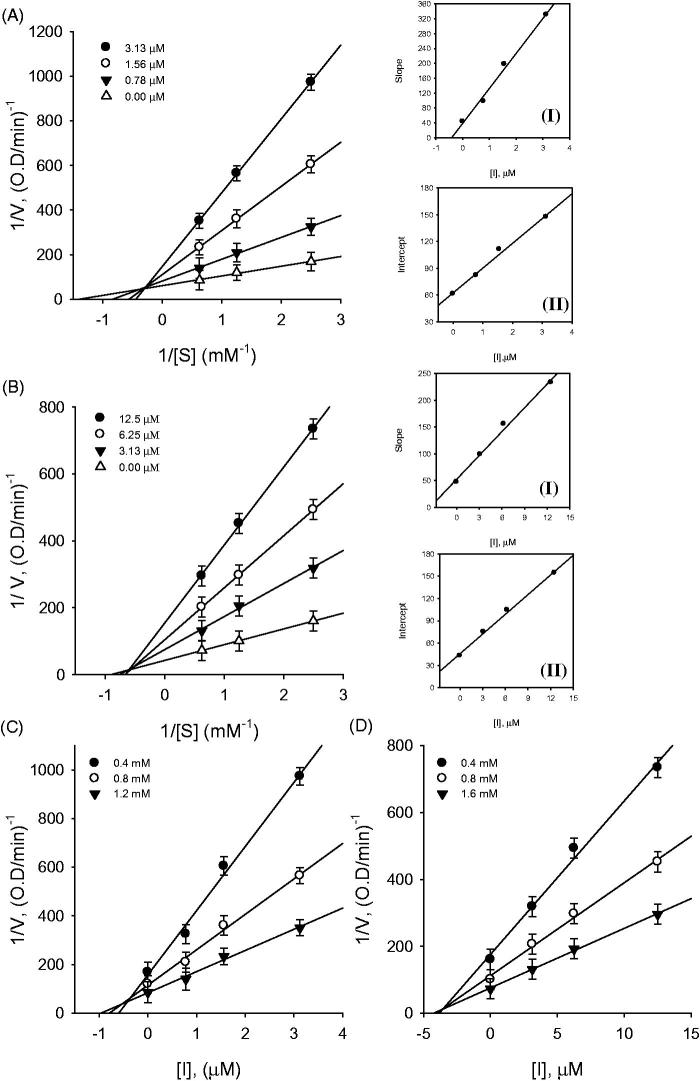
(A–D) Kinetic assays of PTP1B inhibition, caused by compounds 1 and 6. (A and B) Lineweaver–Burk plots were constructed for the inhibition of PTP1B. The plots are expressed as 1/velocity (1/V) versus 1/substrate (1/[S]) with or without inhibitors. Insets (I) and (II) represents the secondary plots of the slopes and the intercepts of the straight lines versus concentrations of compound 1 and 6. (C and D) Dixon plots for inhibition of PTP1B by compound 1 and 6, respectively.